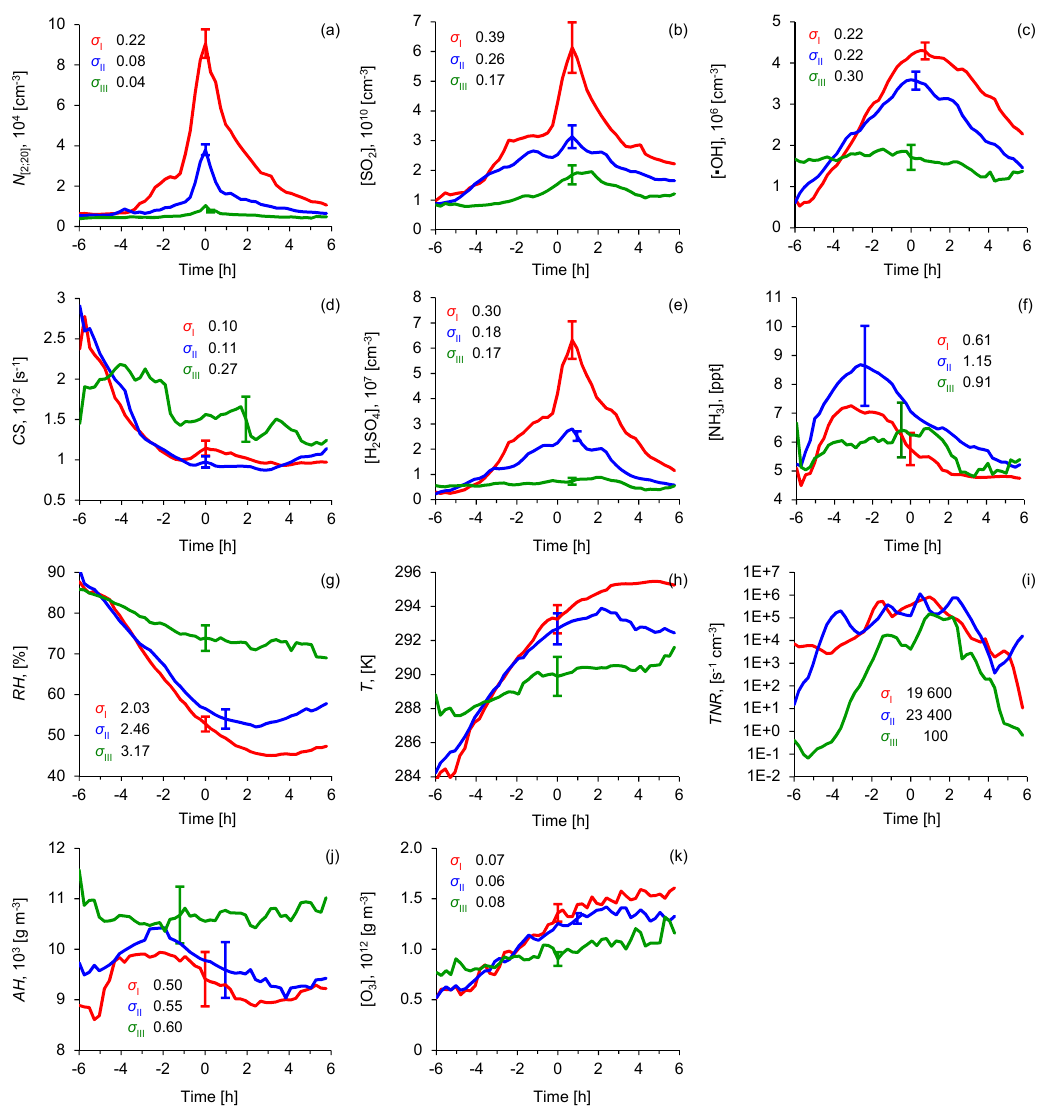
Figure D1. Alternative version of Fig. 6 limited to the years 2010–2011 when experimental ammonia concentrations were available. The graphs show average diurnal cycles of atmospheric parameters for the three NPF event classes: red indicates a Class I event, blue indicates a Class II event, and green represents a Class III event, including weak events and “non-events”. The subfigures show the concentrations (cid:113) of (a) ultrafine particles ( N [2;20] ), (b) sulfur dioxide (SO 2 ), (c) hydroxyl radicals ( OH), (d) the condensational sink (CS), (e) sulfuric acid (H 2 SO 4 ), and (f) ammonia (NH 3 ), (g) relative humidity (RH), (h) temperature ( T ), (i) the calculated ternary nucleation rate (TNR) according to Napari et al. (2002), (j) absolute humidity (AH), and (k) ozone (O 3 ) concentration. The σ values, indicated by whiskers, represent the √ n − 1.) Data coverage: Class I (33 days), Class II standard error of the mean of each subpopulation. (Technically, this is calculated as σ/ (35 days), Class III (40 days). The arithmetic mean event peak times were Class I (10:48CET), Class II (11:54CET), Class III